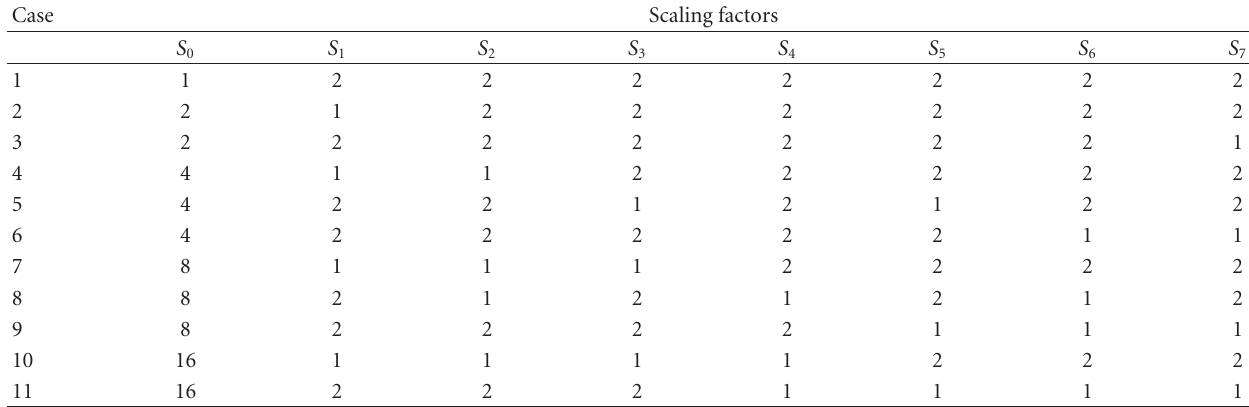
Table 8: 11 cases to demonstrate the accuracy of the FFT-1920.